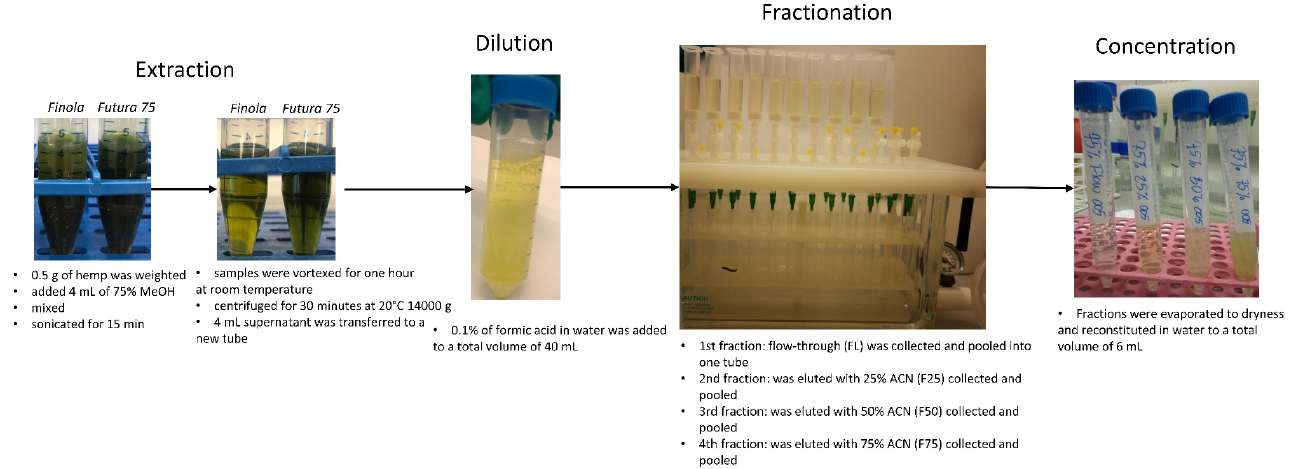
Figure 5. Protocol of systematic extraction and fractionation of Cannabis sativa L. Futura 75 and Cannabis sativa L. Finola .